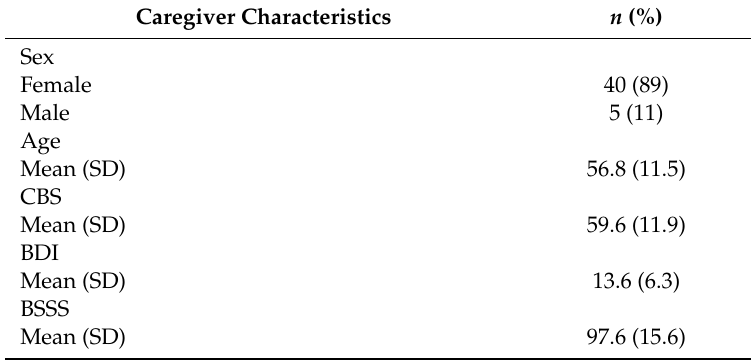
Table 1. Baseline characteristics of the study group ( n = 45) and patients with